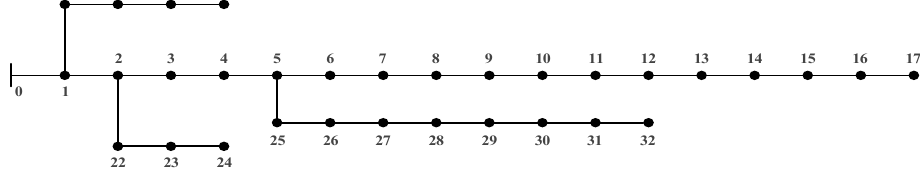
Figure 6. The structure of the IEEE 33-node distributed power network.